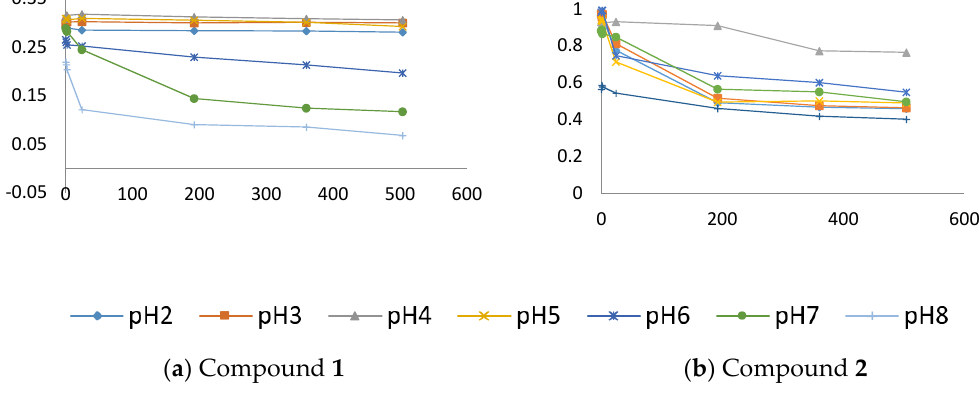
Figure 3. Stabilities of xanthones 1 (( a ) 1,2-DHX; 390 nm) and 2 (( b ) , 310 nm), given by variation in pH buffers over the time of analysis (0, 1, 2, 24, 192, 360 and 504 h) at 200 µM.